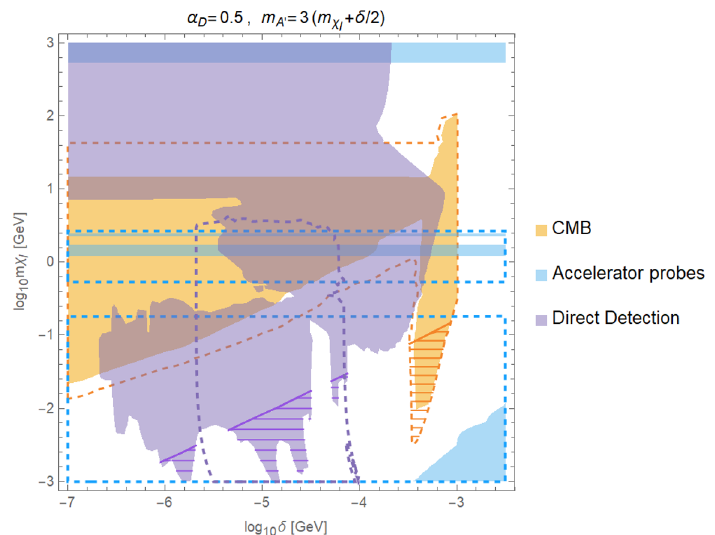
Figure 13 . CMB (mustard), direct detection (purple), and fixed-target (light blue) constraints for α = 0 . 5 and m = 3 ( m + δ/ 2) . The projections for each probe are shown with dashed D A 0 χ l contours of the same color as the excluded regions. In the striated regions, semi-elastic interactions could further deplete the excited state and weaken the exclusions. Details on the CMB, accelerator probes, and direct detection bounds can be found in figures 5, 7, and 9 respectively. The direct detection projections correspond to SuperCDMS and LZ, but for this choice of α is relevant.Analogous plots for additional dark-sector benchmarks are shown in figure